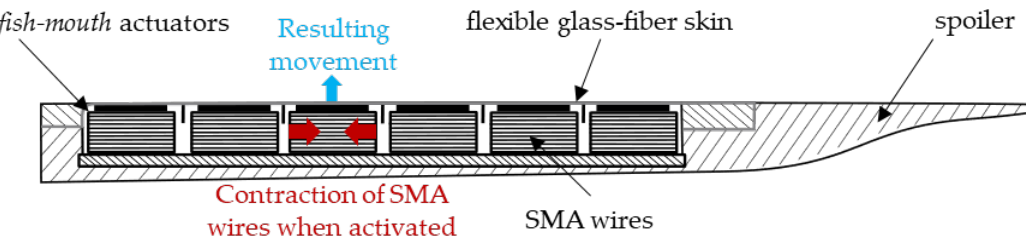
Figure 6. Arrangement of several fish-mouth actuators with shape memory alloy (SMA) wires in a spoiler of an aircraft wing based on [71,72].